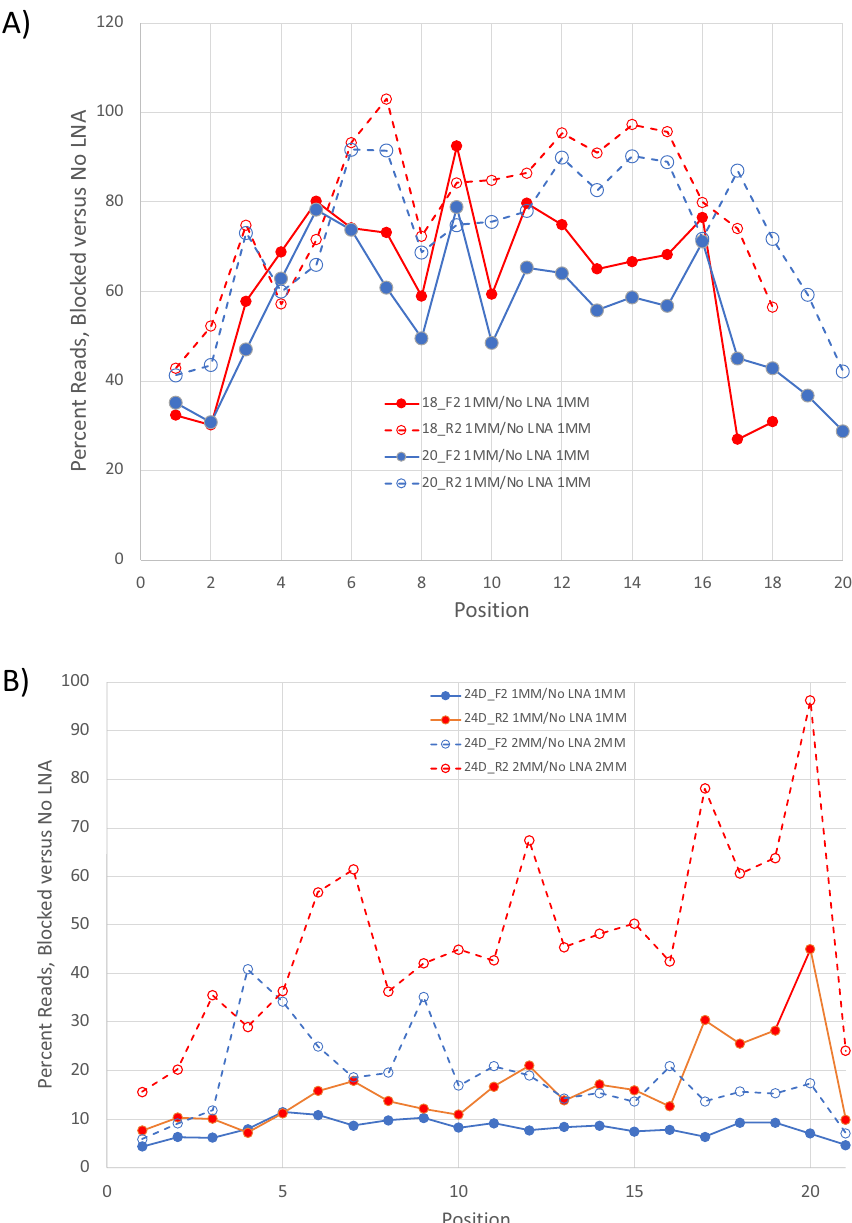
Figure 4. Blocking as function of position. ( A ) The relative read frequency for amplification with blockers versus amplification with no LNAs is shown as a function of position. In panel A, the frequency of reads with single mismatches is shown for 18 (red) and 20 (blue) nt LNA blockers. Blockers identical to the forward strand are shown with solid lines/symbols, and blockers identical to the reverse strand are shown with dashed lines/ open symbols. The overall shape for all forward primers and for all reverse primers is similar. ( B ) LNAs blockers that cover 21 degenerate positions are shown with data for reads for one mismatch (1MM, solid lines/symbols) and for reads with two mismatches (2MM, dashed lines/open symbols). Blockers identical to the forward strand are shown in blue, and the reverse strand in red. Blocking in the presence of mismatches is not necessarily desirable as it indicates a lack of